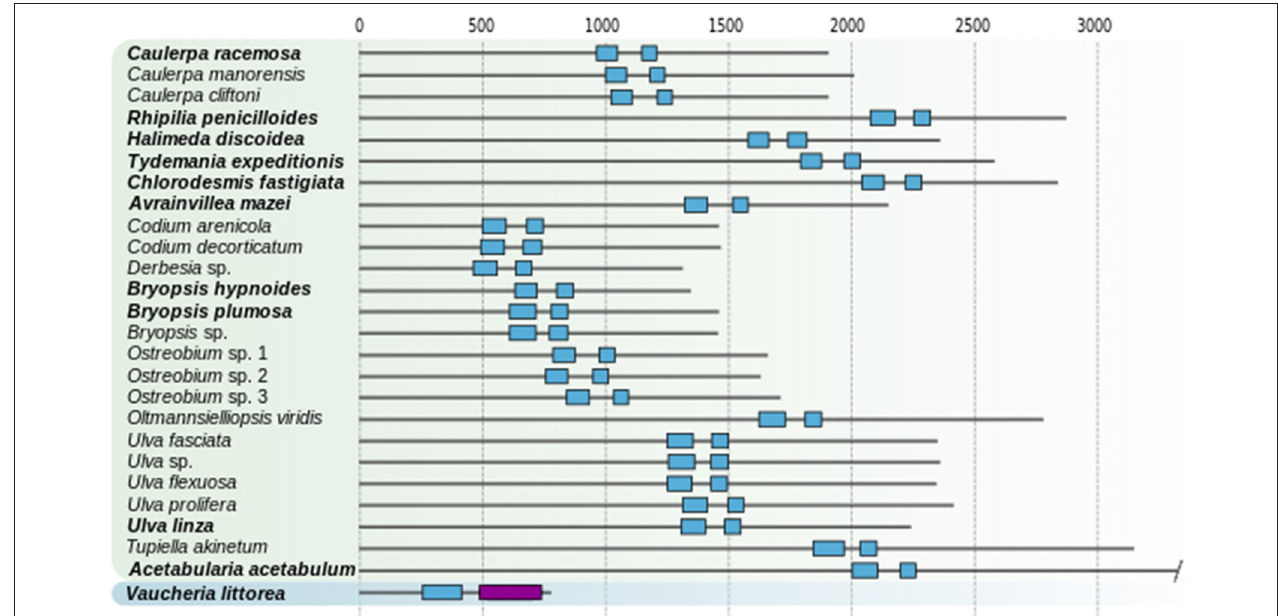
FIGURE 7 | Domain architecture of FTSH proteins in Ulvophyceae and one heterokontophyte. Sacoglossan food sources are highlighted in bold. Ulvophyceae highlighted in green box, the heterokontophyte in